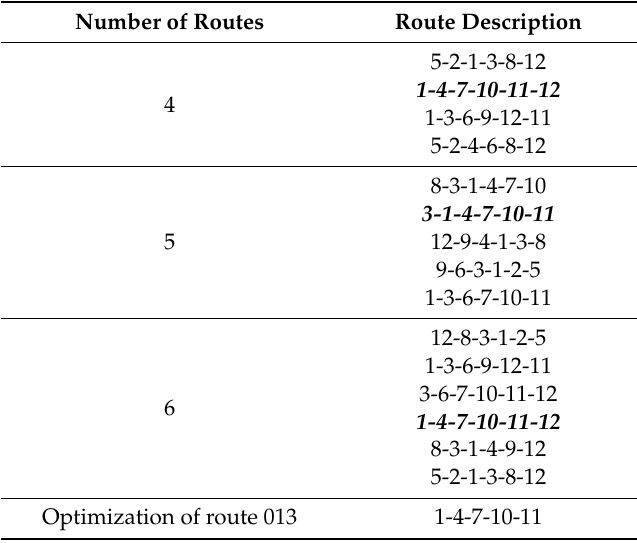
Table 10. A final solution obtained by genetic algorithm for the transport